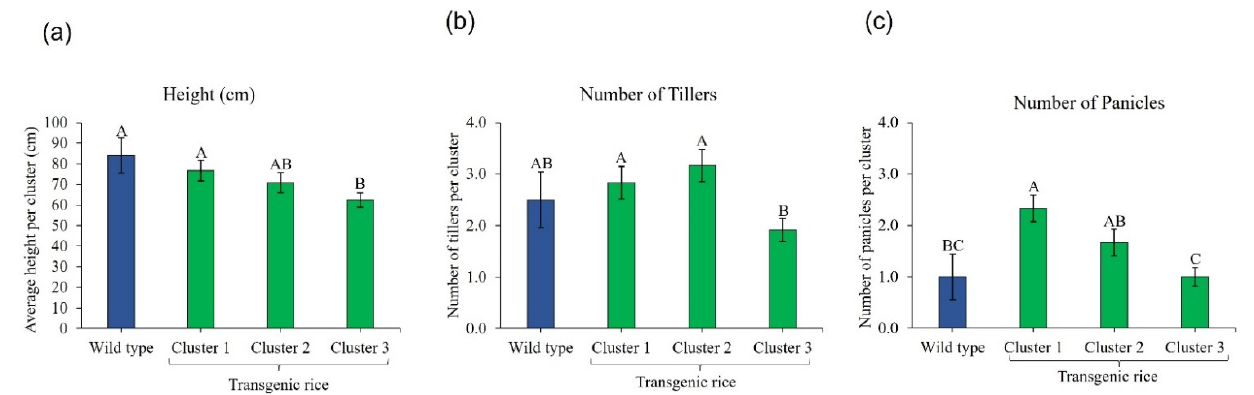
Figure 3. Phenotypic data of T 2 rice plants that survived 390 g ai ha − 1 soil-applied fomesafen. ( a ) Height, ( b ) number of tillers, and ( c ) number of panicles of T 2 survivors by phenotypic trait cluster. Data were collected when the majority of survivors transitioned to the reproductive stage. Significant means were separated using Fisher’s protected LSD ( p < 0.05). Means with different letters above bars are different ( p < 0.05).